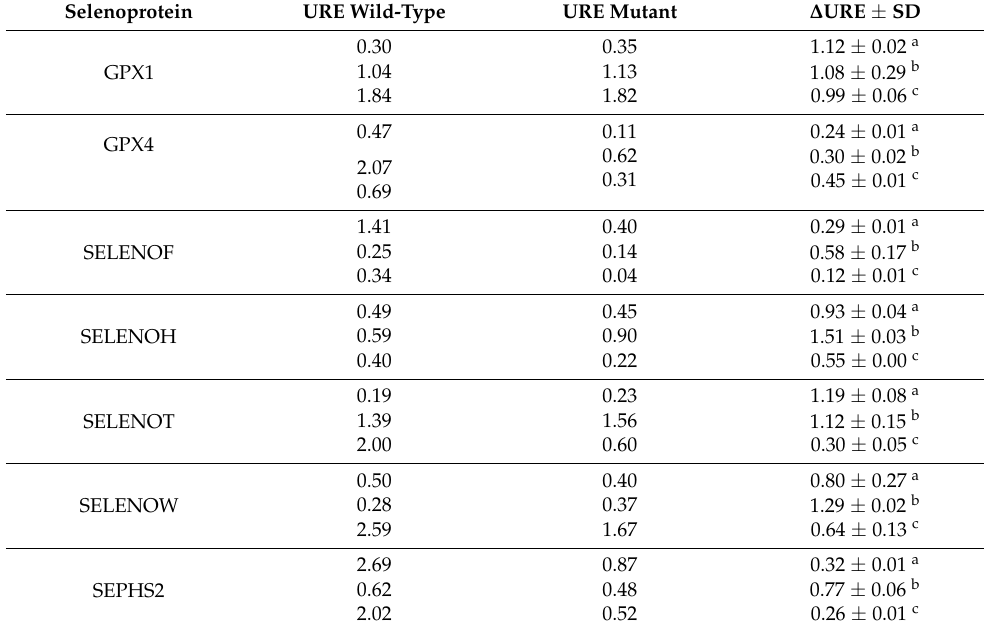
Table A1. Effects of mutations in SECISBP2 genes on UGA re-coding efficiency (URE) of selenoproteins. Selenoprotein URE Wild-Type